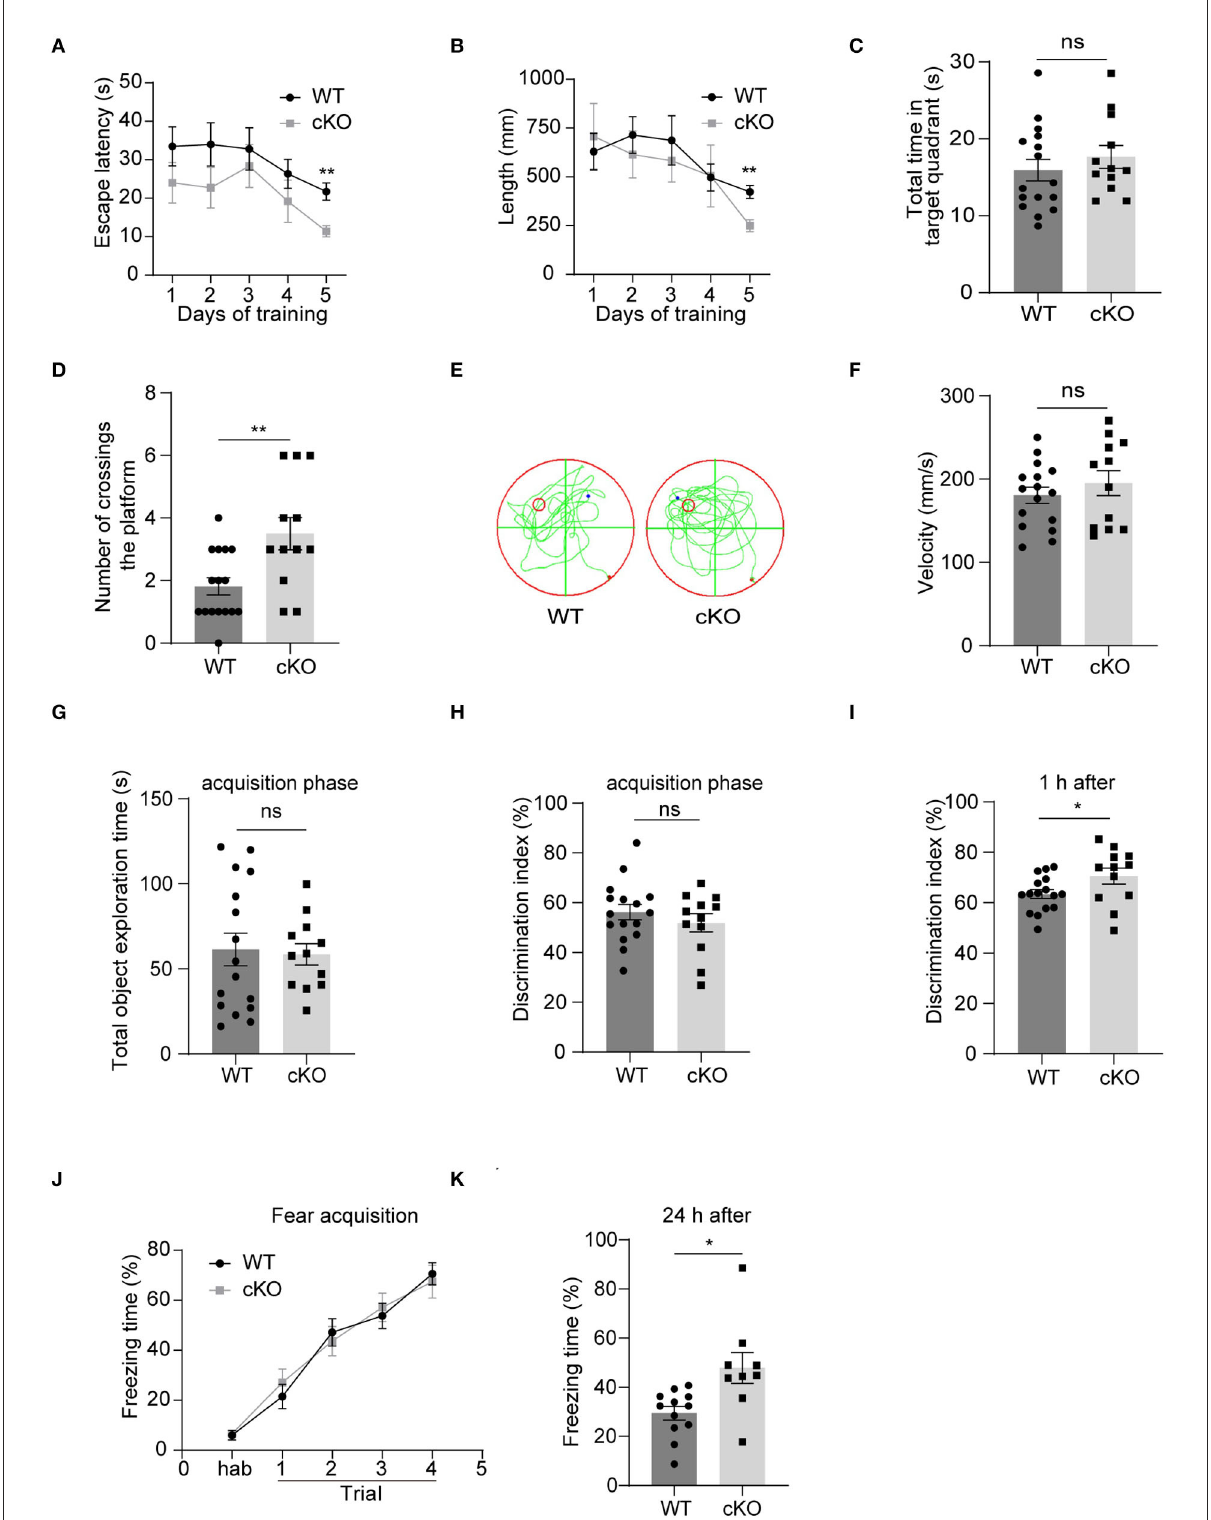
FIGURE4 The MAD2B cKO mice showed increased hippocampus-dependent learning and memory abilities. (A) Escape latency during training days in MWM (multiple- t -test, p = 0.22 on day1, p = 0.17 on day2, p = 0.58 on day3, p = 0.27 on day4, p = 0.001 on day5). (B) Escape length